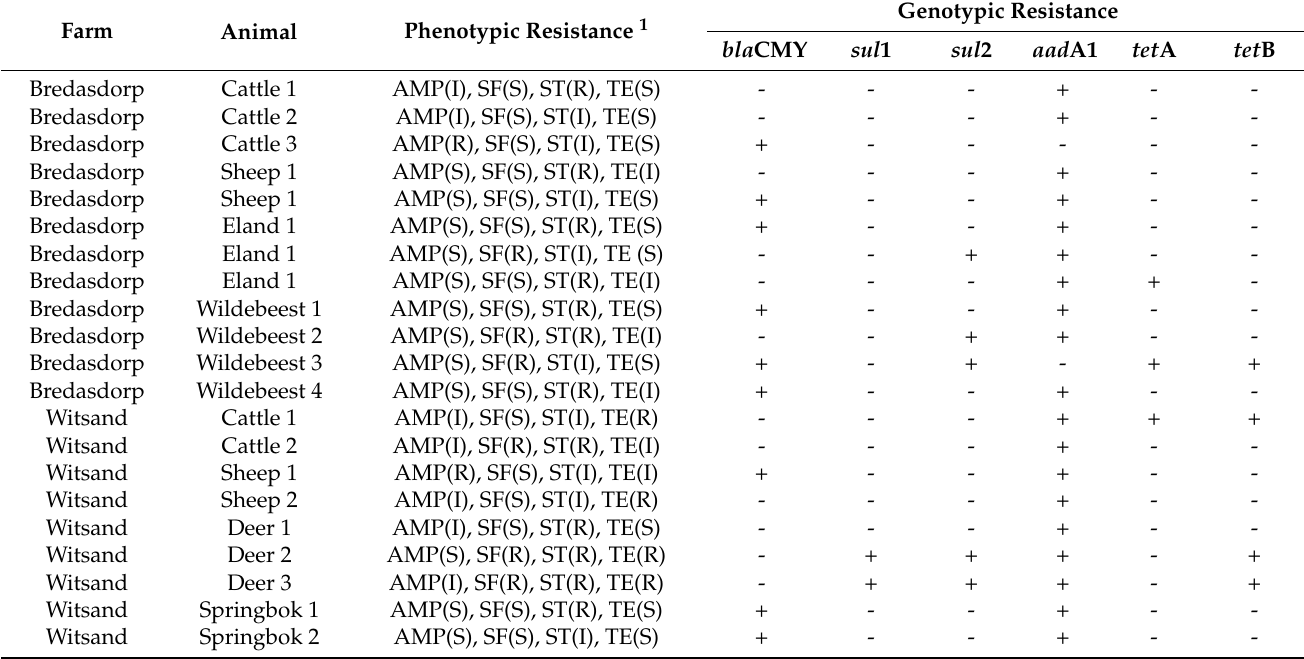
Table 1. Correlation between E. coli phenotypic antibiotic resistance and PCR